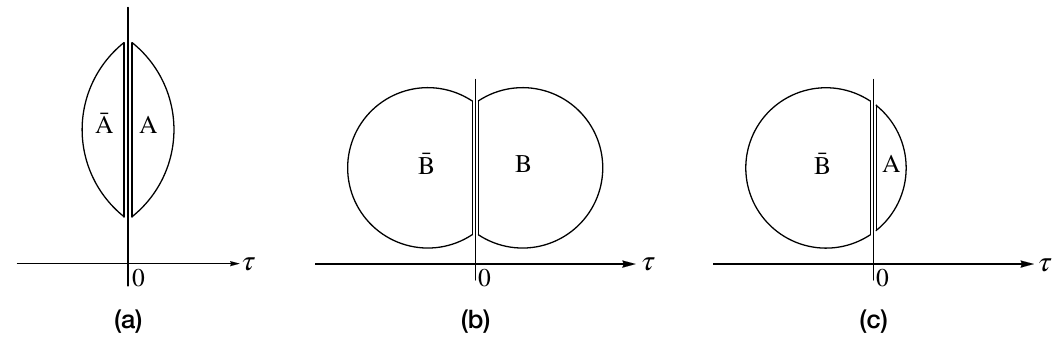
Figure 11: (a) Regions A and ¯ A . ¯ A is the Euclidean time-reflected image of A with respect to τ = 0. The two regions touch each other at the τ = 0 plane, and we take the limit of no separation. Together A ∪ ¯ A has two sharp corners. (b) Regions B and ¯ B . (c) Regions A and ¯ B . A ∪ ¯ B has no